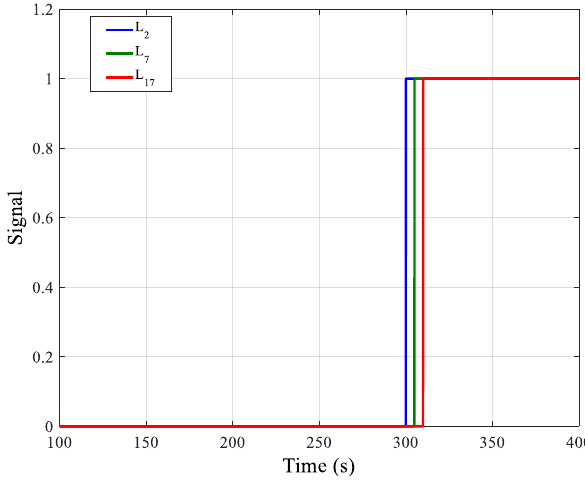
Figure 10. Circuit breaker signals of fault 3.